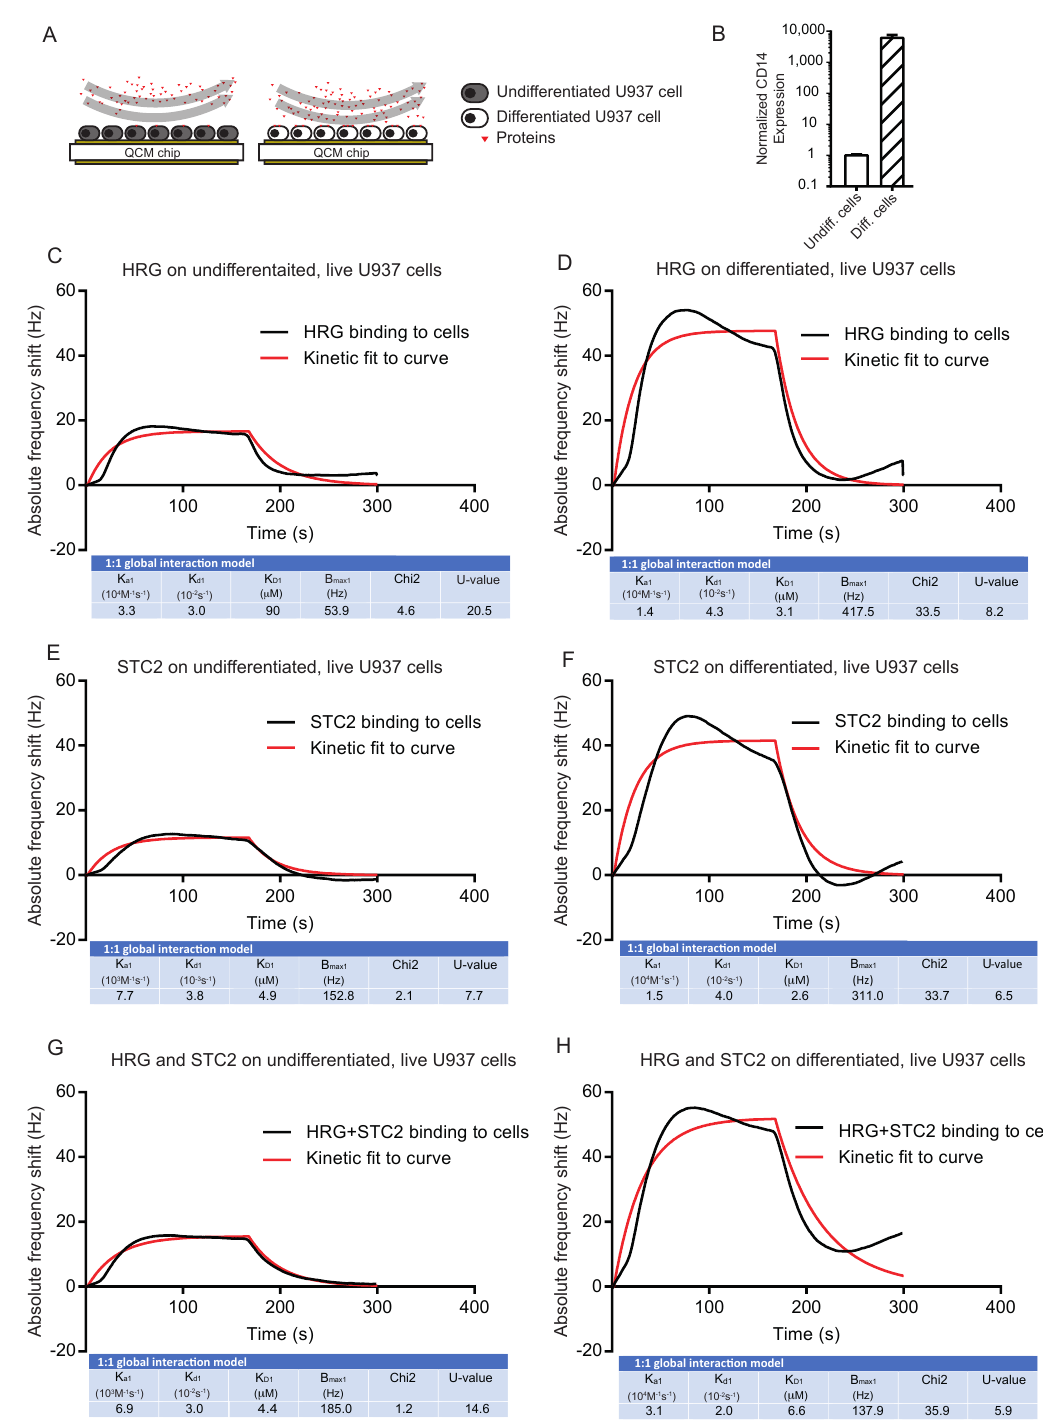
Figure 3. Binding of HRG and STC2 individually and together to live U937 cells. ( A ) Schematic outline of the experimental setup. Undifferentiated or vitD3 differentiated U937 cells, immobilized on QCM LNB chips with HRG, STC2 or a mix of the two, injected over chip surfaces. ( B ) Real-time qPCR data of CD14 expression normalized to GAPDH on undifferentiated and vitD3 differentiated U937 cells seeded on the QCM chip. Three independent analyses. ( C – F ) Representative sensorgram showing frequency response from injections over undifferentiated ( C , E , G ) and vitD3 differentiated ( D , F , H ) live U937 cells. Black lines: experimental curves. Red lines: fitted curves of the 1:1 interaction model. For representative sensorgrams shown, three injections per concentration, two independent